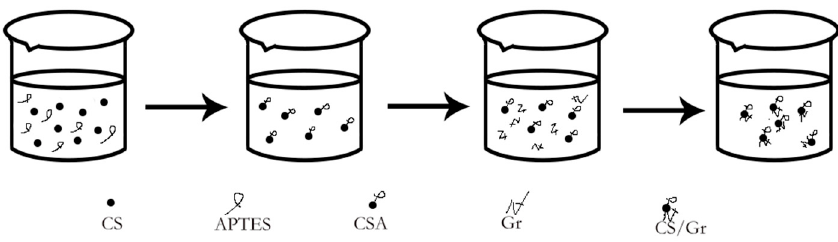
Figure 2. Modification mechanism of CS / Gr modified bamboo fiber fabrics (CGBFs). Figure 2. Modification mechanism of CS/Gr modified bamboo fiber fabrics (CGBFs). Figure 2. Modification mechanism of CS/Gr modified bamboo fiber fabrics (CGBFs). Figure 2. Modification mechanism of CS/Gr modified bamboo fiber fabrics (CGBFs).